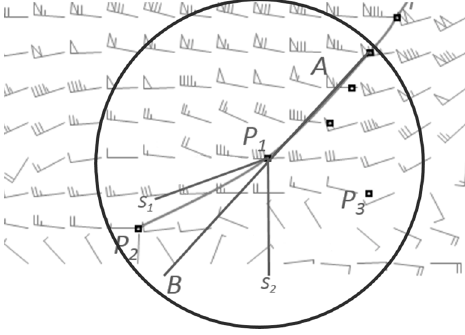
Figure 1. The constraint conditions for longwave trough line seeking.